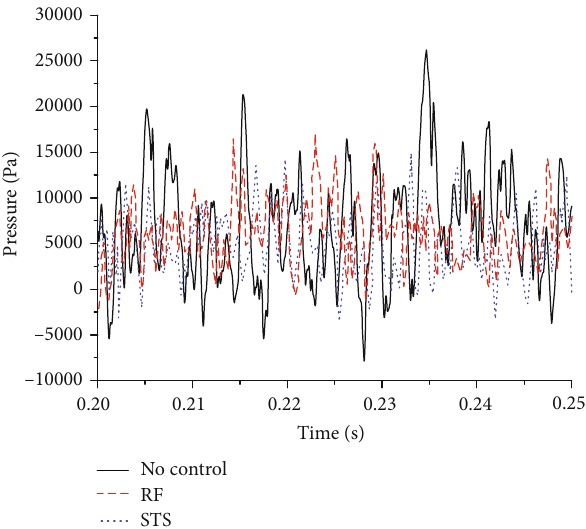
Figure 12: Pressure trace from 0.2s to 0.25s ( X / L = 0 : 95 ).